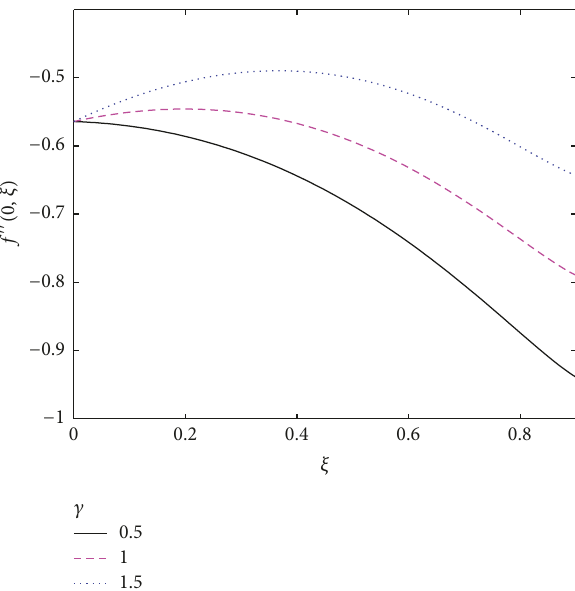
Figure 10: Effect of 𝛾 on 𝑓 󸀠󸀠 (0,𝜉) ( 𝜎 = 0.5 𝜆 = 0.5, Pr = 3, Sc = 2, ℏ = −0.5 ).